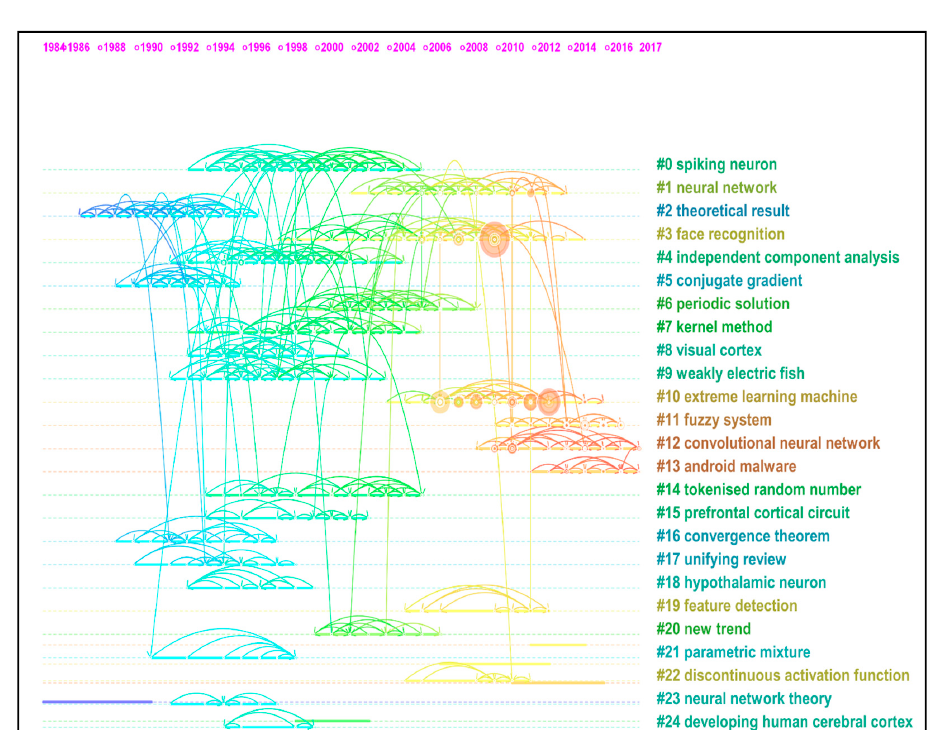
Figure 12. Timeline view of the document co-citations.